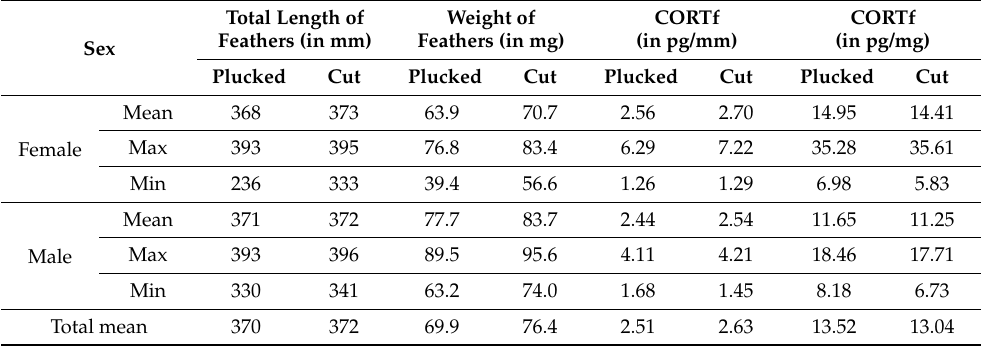
Table 2. Overview of the measured results (total feather length, weight of feathers, and CORTf) of 46 Greater Flamingos ( Phoenicopterus roseus ) compared between sexes, with 26 females and 20 males, and sampling method (plucked vs. cut); 7 to 10 feathers were used for